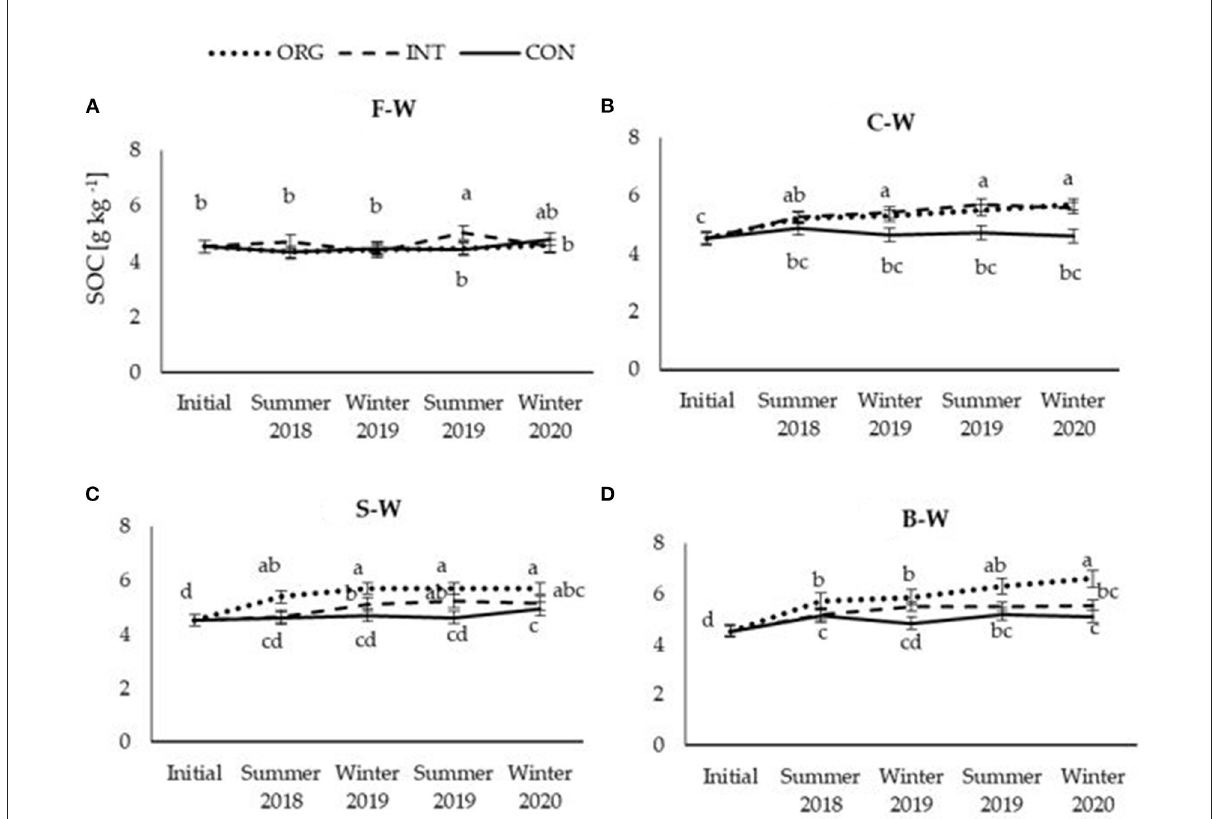
FIGURE4 Interaction effects of four seasonal weather variations, three agricultural strategies (conventional, CON; organic, ORG; and integrated management strategy, INT), and four crop rotation systems: (A) F-W, fallow-wheat; (B) C-W, corn-wheat; (C) S-W, sesame-wheat, and (D) B-W, mung bean-wheat, on SOC change. The initial point indicates the measured values at the start of the experiment. The years depict the harvest time for winter and summer crops. Letters indicate a significant (different letters) and no significant (Identical letters) difference at p ≤ 0.05 according to Duncan’s multiple range